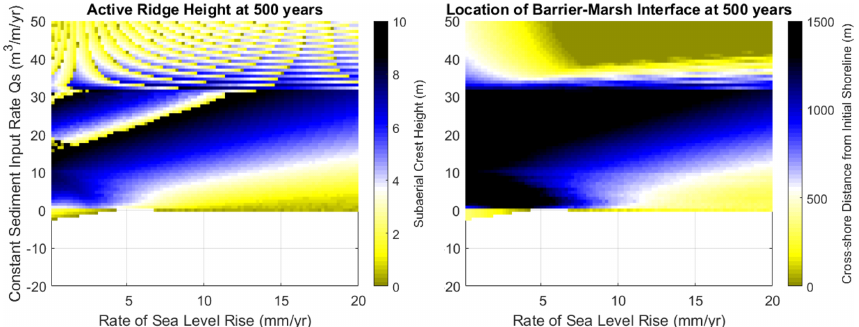
Figure 10. Plots of active foredune crest height H and barrier–marsh interface location x b for a 500-year simulation of a modeled barrier with input parameters described by Table 3 where D T = 2 . 5m. Regions with no data (generally negative sediment input) correspond with complete destruction of the barrier’s subaerial superstructure. D T is the thickness of the barrier substructure or the depth of the active shoreface over decadal timescales. Q S represents shoreface flux, and x b represents the cross-shore location of the backbarrier–marsh interface.